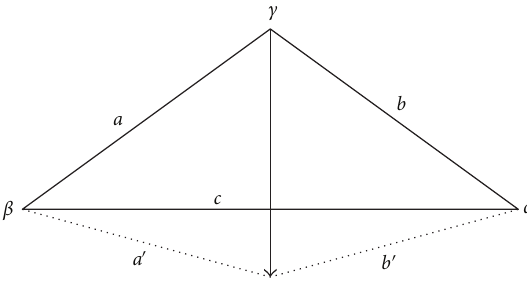
Figure 10: Curvature angle and filter.